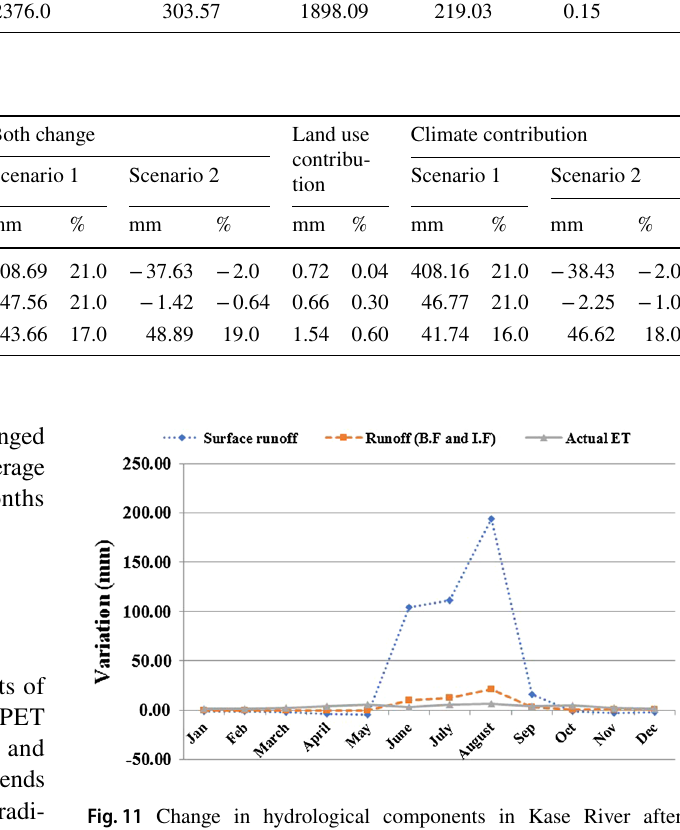
Fig. 11 Change in hydrological components in Kase River after 100 years under CC-scenario